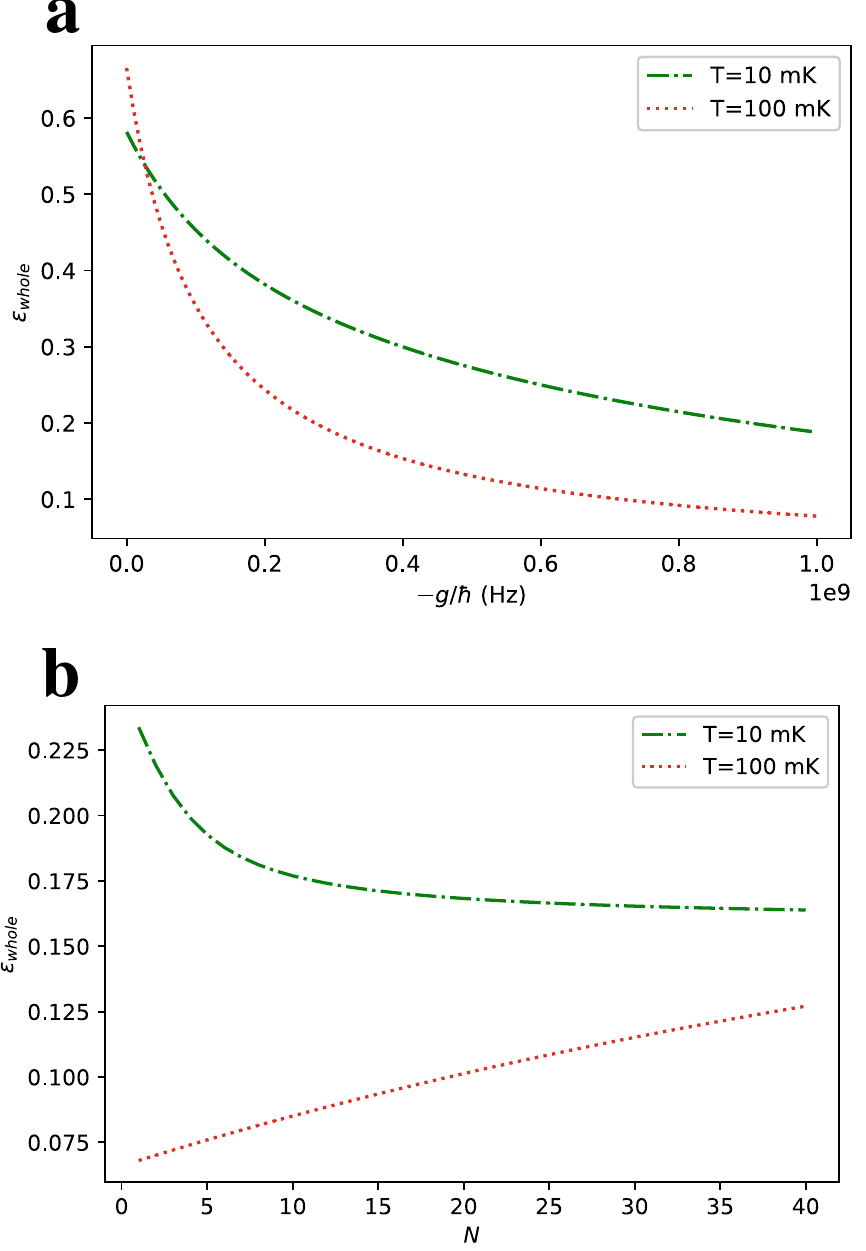
Figure 6. Efficiency ε whole defined in Eq. (19) as a function of ( a ) interaction strength g with N = 6 and ( b ) number of ancilla qubits N with g = − h at different environment temperatures T . We take h = 1